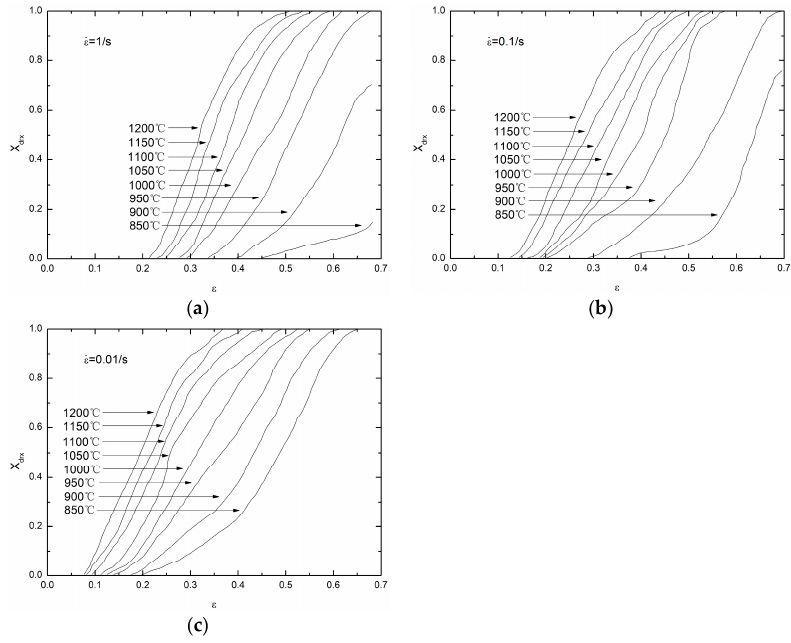
Figure 13. The X drx - ε curves on different temperatures and strain rates: ( a ) 1/s; ( b ) 0.1/s; ( c ) 0.01/s.